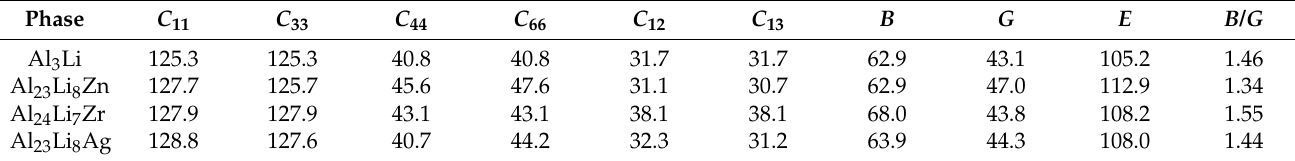
Table 2. Computed elastic constants C ij (GPa), bulk modulus B (GPa), shear modulus G